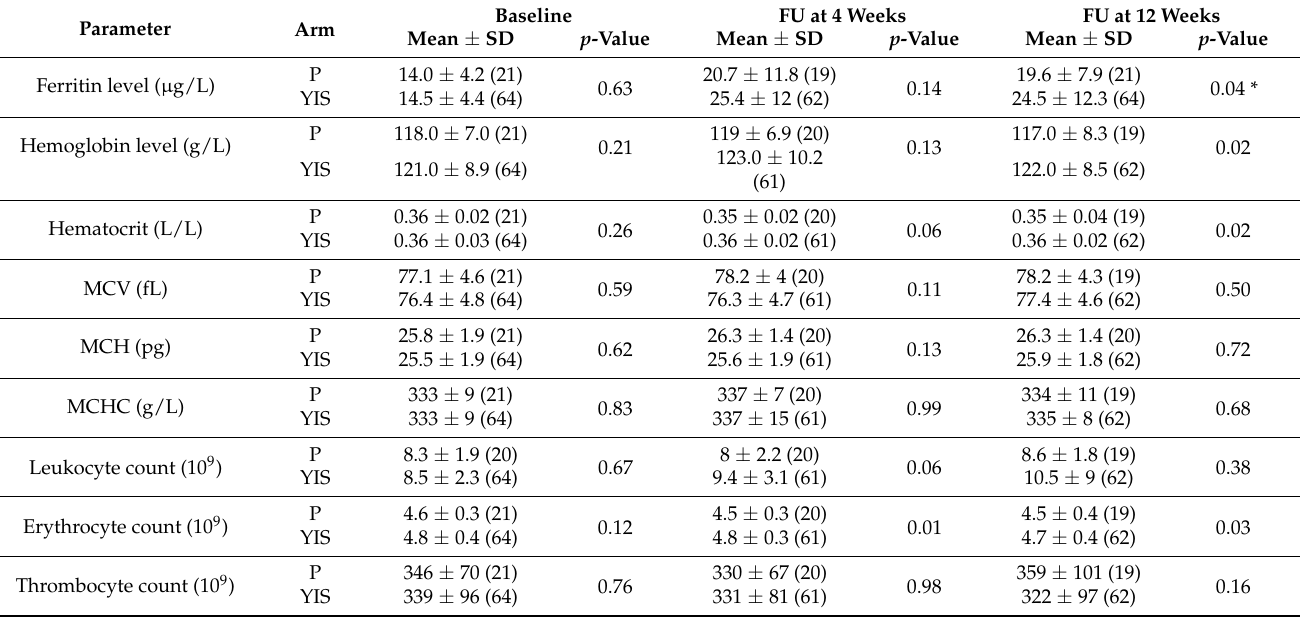
Table 2. Comparison of participant hematological characteristics and iron status between baseline and the 4-week and 12-week follow-up.